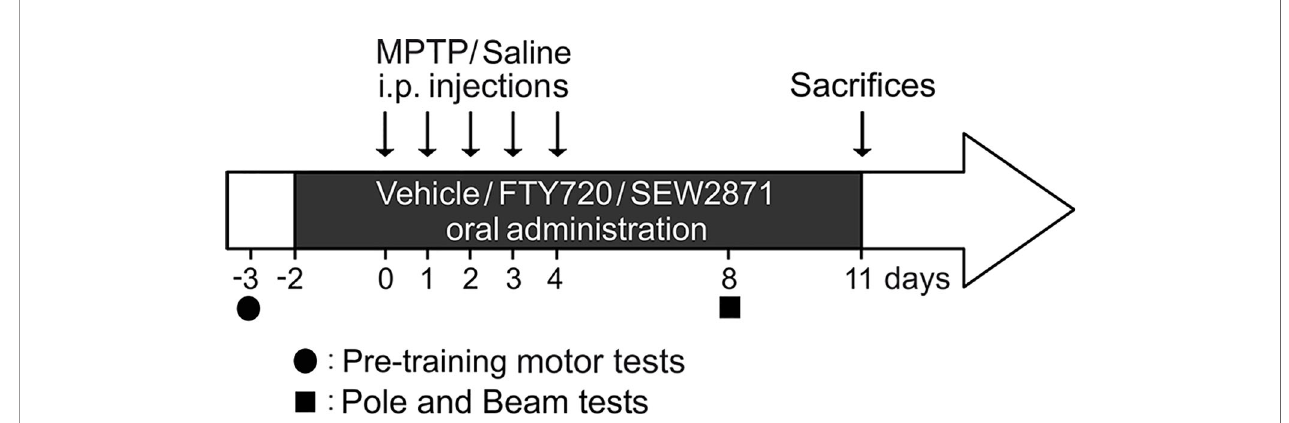
FIGURE 1 | Experimental design. Three days before 1-methyl-4-phenyl-1,2,3,6-tetrahydropyridine (MPTP) injections, mice were pre-trained at the pole and beam tests by completing three trials within a day. Two days before MPTP injections, mice received an oral treatment with either vehicle [10% dimethyl sulfoxide (DMSO) and 25% Tween 20 v/v dissolved in saline 0.9% sodium chloride], FTY720 (1 mg/kg), or SEW2871 (20 mg/kg) once a day for a total of 14 days. At day 0, saline or MPTP (30 mg/kg/day) treatments were administered i.p. during 5 days. Motor abilities at the pole and beam tests were evaluated 8 days after the fi rst MPTP injections. On day 11, all mice were sacri fi ced. The experimental setting involved six groups: 1) vehicle with saline treatments, n = 3; 2) FTY720 with saline treatments, n = 3; 3) SEW2871 with saline treatments, n = 3; 4) vehicle with MPTP treatments, n = 5; 5) FTY720 with MPTP treatments, n = 5; (6) SEW2871 with MPTP treatments, n =